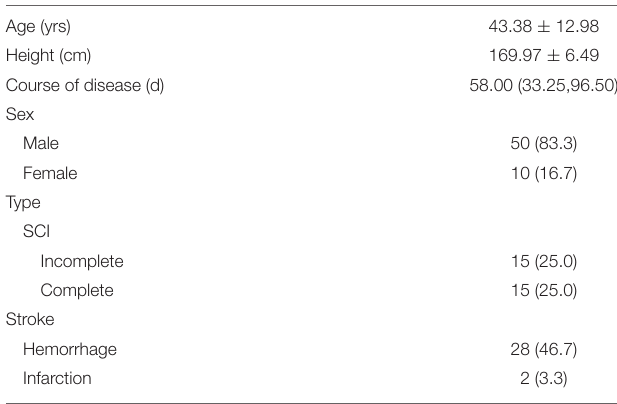
TABLE 1 | Demographic characteristics of subjects ( n =